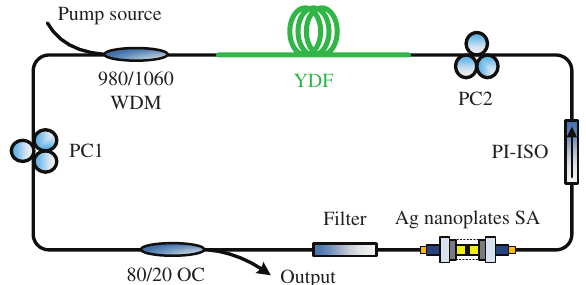
urable absorption property is schematically shown in Figure 5A. The output of the home-made 1- μ m mode-locked fiber laser source is modulated by a variable optical atten- uator and divided by a 95:5 optical coupler. Ninety-five percent of the power passes through the Ag nanoplates SA and is measured by a power meter, while the other 5% is monitored by another reference power meter. The non- linear transmittance of the Ag nanoplates SA is shown in Figure 6, as a function of the incident fluence. Fitted with